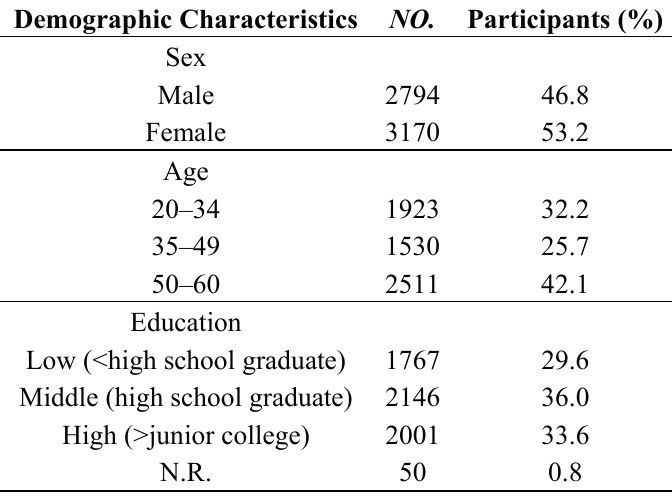
Table 2. Characteristics of 5964 study participants who responded to a questionnaire on sun